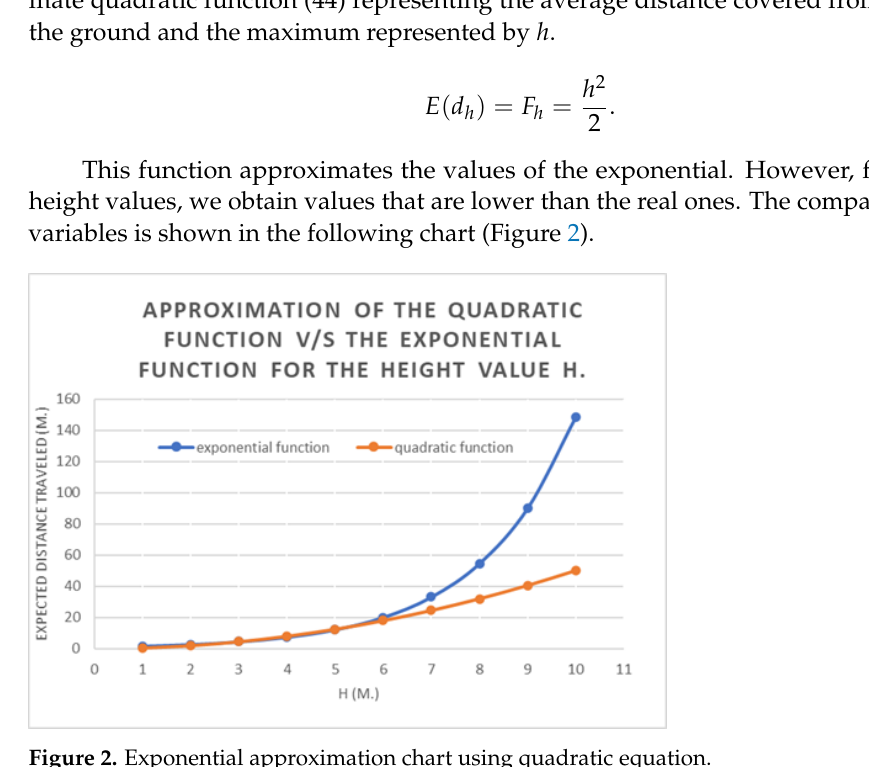
Figure 2. Exponential approximation chart using quadratic